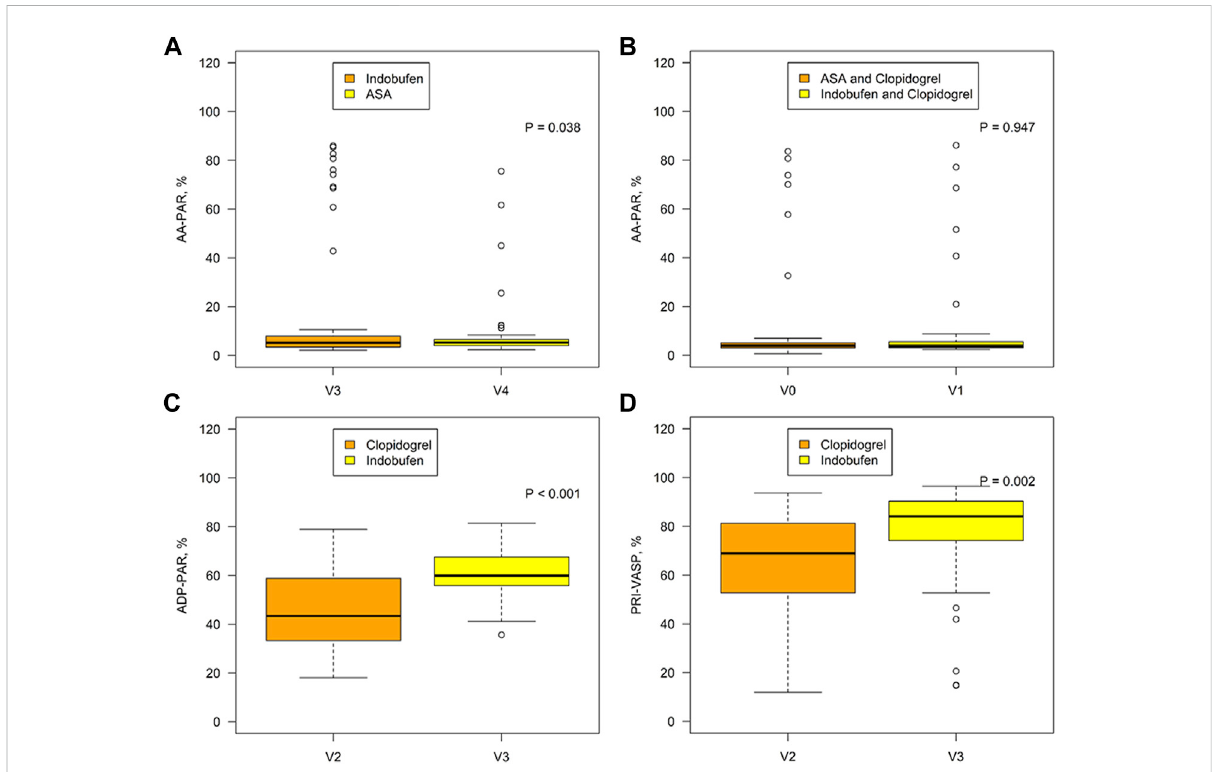
FIGURE 2 Comparison of theAA-PAR between theindobufenalonegroup (V3)and theaspirin alone group (V4) (A) and betweentheaspirin + clopidogrel group (V0) and the indobufen + clopidogrel group (V1) (B) . Comparison of the ADP-PAR (C) and PRI-VASP (D) between the clopidogrel alone group (V2) and the indobufen alone group (V3). AA-PAR = rate of arachidonic acid-induced platelet aggregation; ADP-PAR = rate of